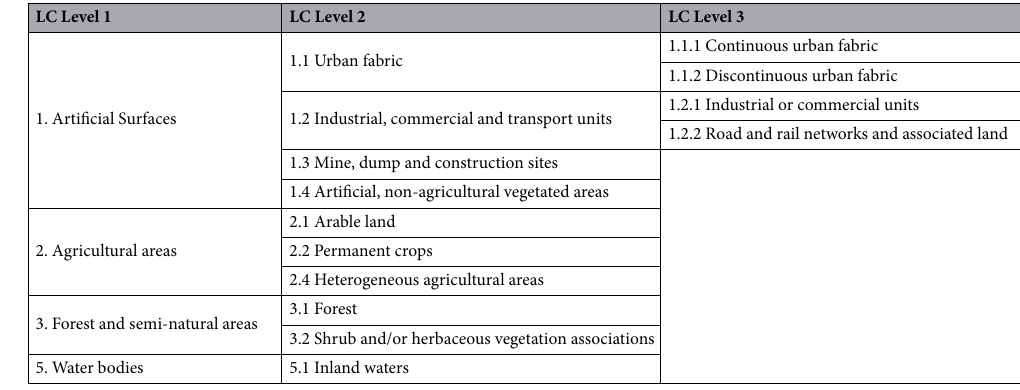
Table 1. Classification scheme of the study.